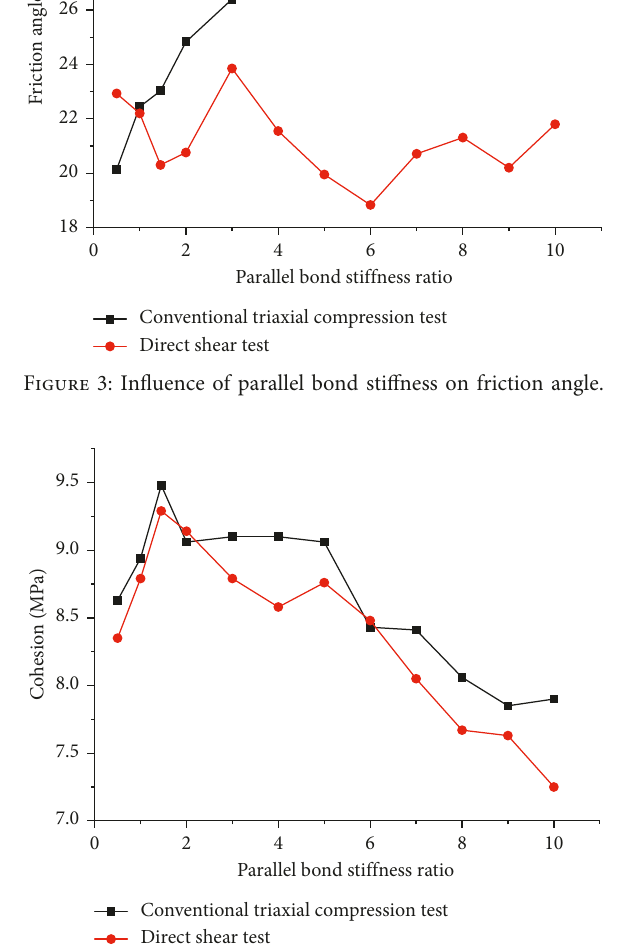
Figure 4: Influence of parallel bond stiffness on cohesion.